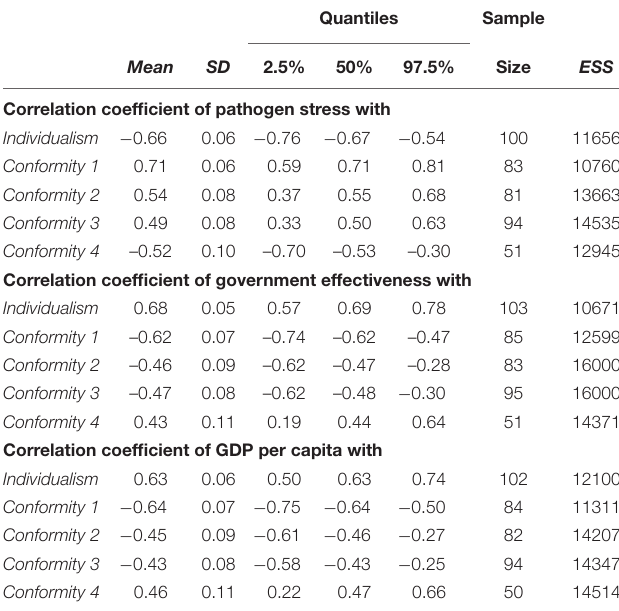
ESS represents effective sample sizes of MCMC